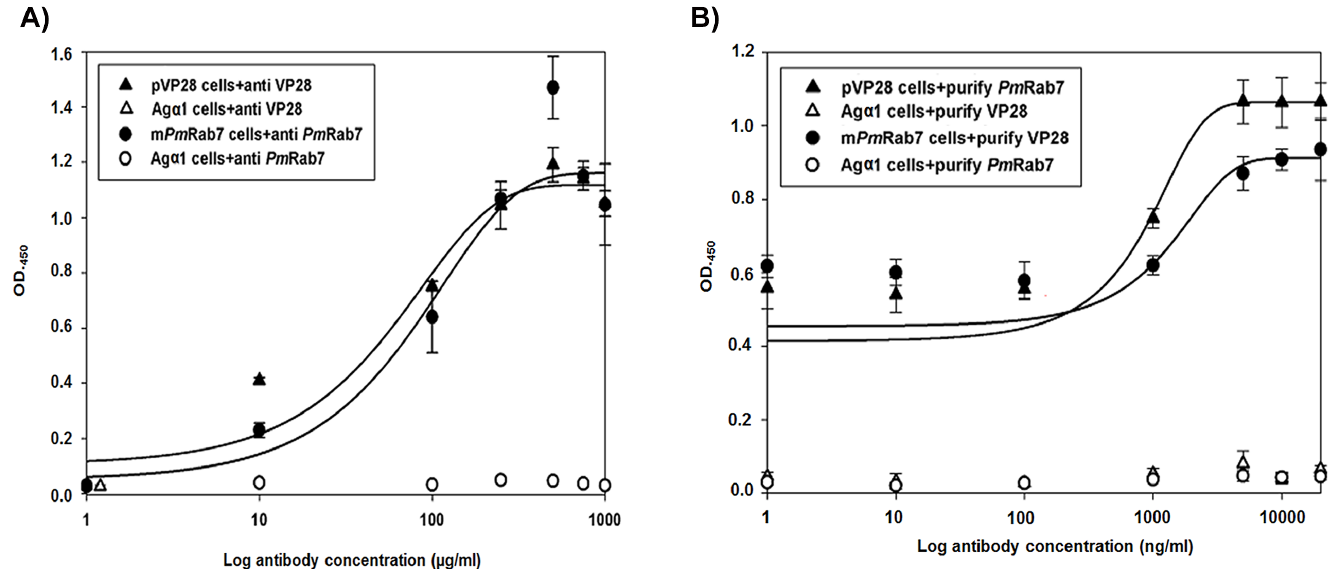
Fig 3. Quantification of m Pm Rab7 and pVP28 on the cell surface of P . pastoris by (A) indirect ELISA and (B) sandwich ELISA. The quantity of methanol-induced His + Mut S yeast cells was 10 8 cells/ml (OD 600 = 10). The values were obtained from three independent experiments. Bar = means ± SD.